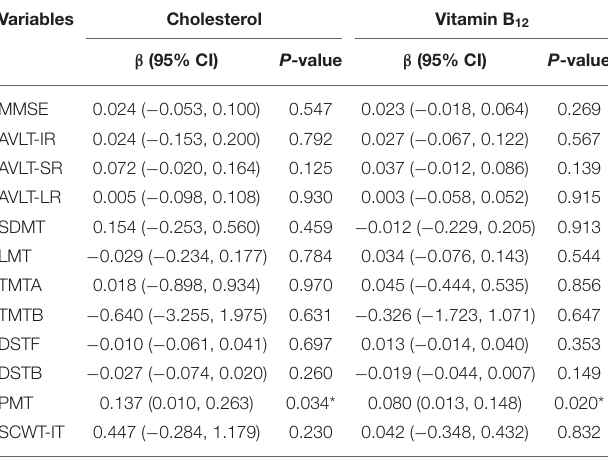
TABLE 3 | Linear relationship between cholesterol or vitamin B 12 and multi-domain cognitive function. Variables